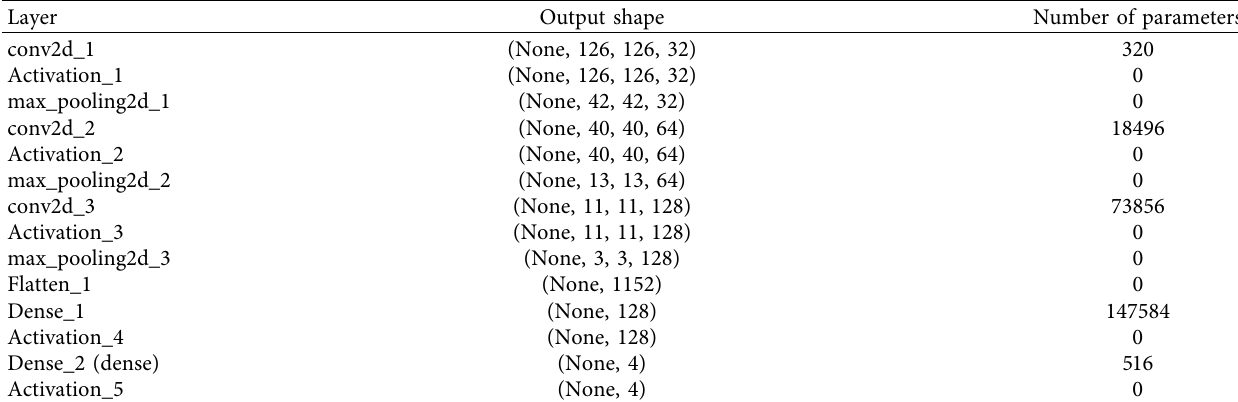
Table 1: Sequential parameter model.